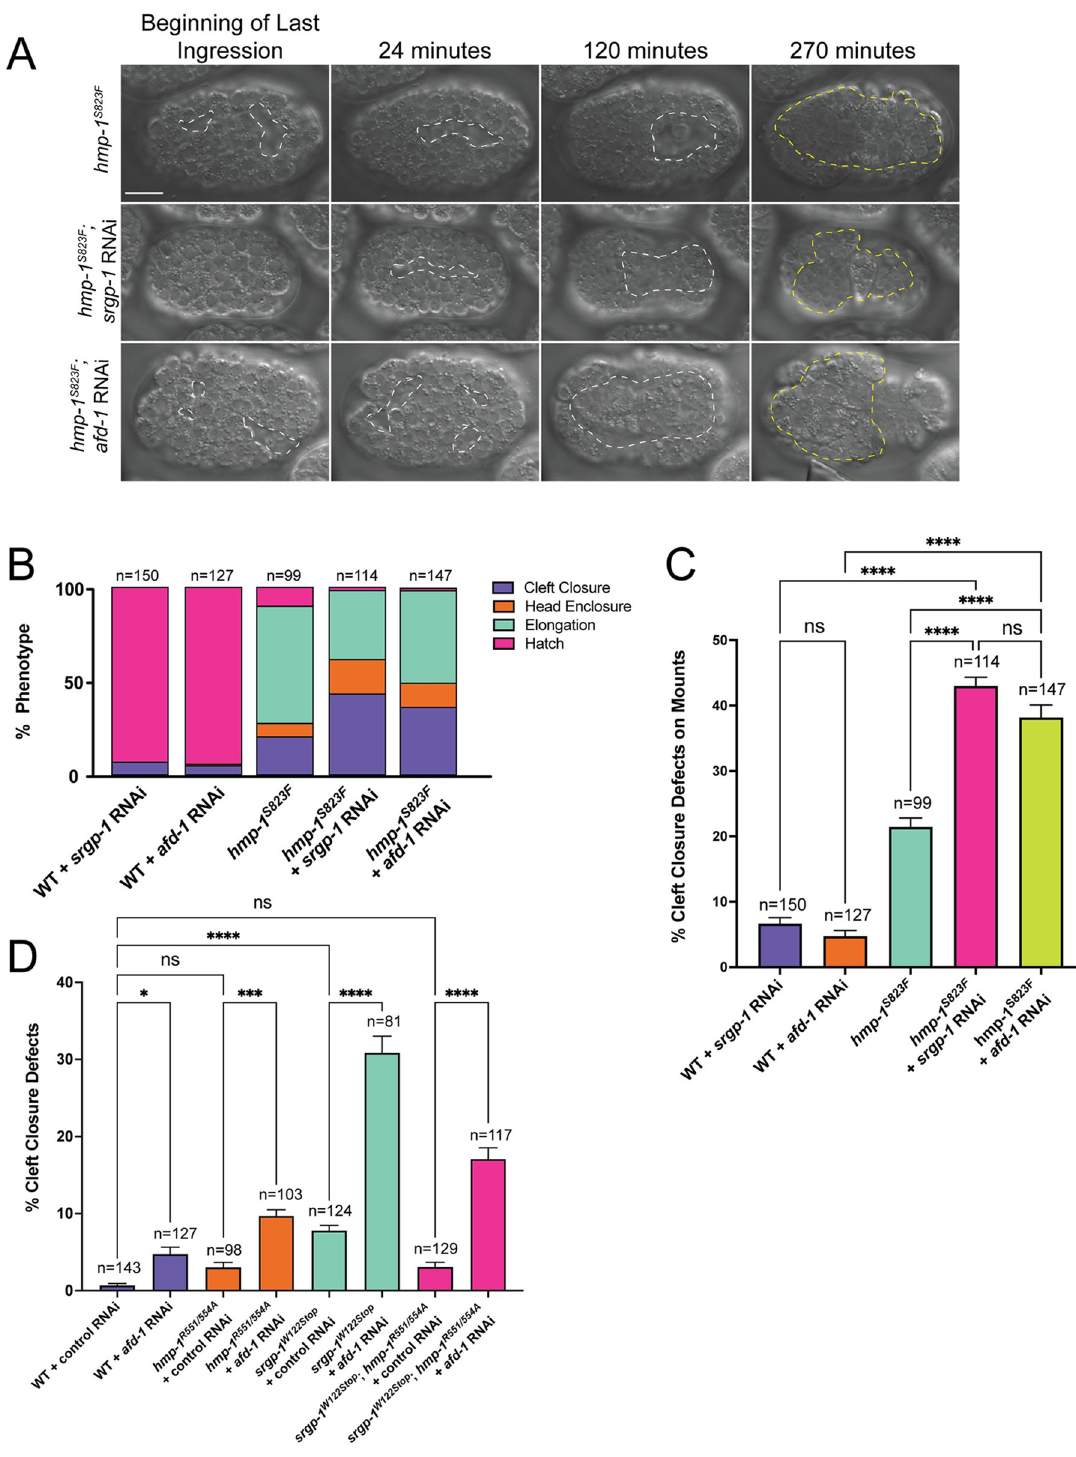
Fig 5. srgp-1 and hmp-1 genetically interact with afd-1 during cleft closure. (A) DIC images of hmp-1 S823F , hmp-1 S823F ; srgp-1(RNAi) , and hmp-1 S823F ; afd-1(RNAi) embryos over the course of 270 minutes. Dotted white lines outline the ventral cleft. Yellow dotted lines indicate extruded gut. Scale bar is 10 μ m. (B) A stacked bar plot indicating the percentage of embryos that die during cleft closure, head enclosure, and elongation in various genetic backgrounds. afd-1 and srgp-1 knockdown in the hmp-1 S823F background both significantly increase the percentage of cleft closure defects. (C) Percent cleft closure defects in various genetic backgrounds with or without depletion of srgp-1 and afd-1 via RNAi. (D) Percentage of cleft closure defects in embryos treated with Control or afd-1 RNAi. ���� , p < 0.0001; ��� , p < 0.001; � , p <